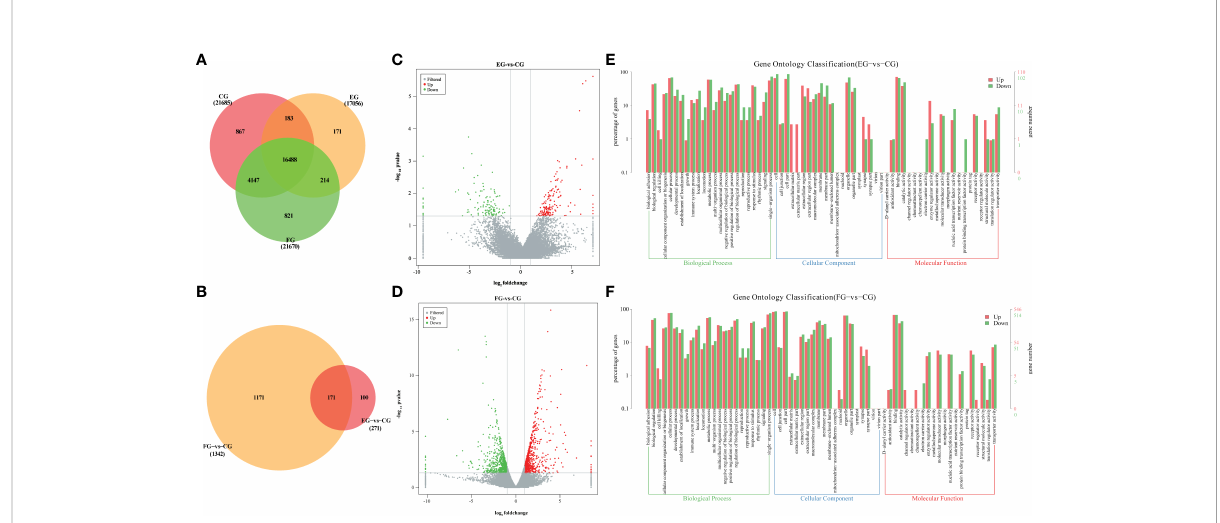
FIGURE 4 Antibiotics modulated genes expression in the intestine of grass carp. (A) Venn diagram of annotated genes in different groups (CG, EG and FG). (B) Venn diagram of DEGs in different antibiotic diets groups compared with control group (EG- vs -CG and FG- vs -CG). (C, D) Volcano plots of DEGs between the enro fl oxacin group (C) and fl orfenicol group (D) compared with control group, respectively. (E, F) Gene ontology (GO) classi fi cation in second level of the unigenes between the enro fl oxacin group (E) and fl orfenicol group (F) compared with control group,